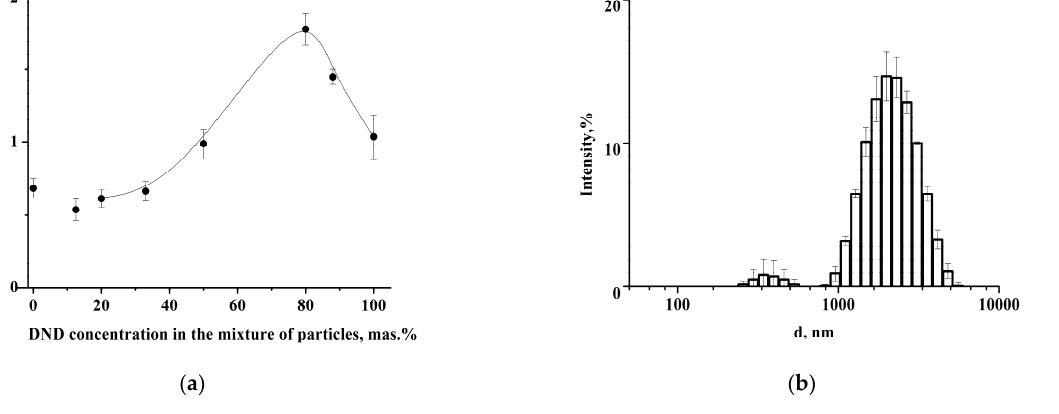
Figure 1. ( a ) Dependence of the hydrodynamic size of the aggregates on the DND content (PBS, pH 8); ( b ) the size distribution of the aggregates at 80 wt.% of DNDs in particle